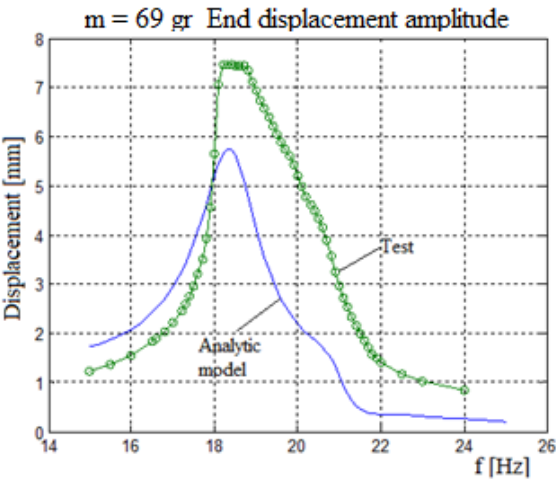
Figure 14. Two bimorphs system amplitude—analytical vs. experimental results.